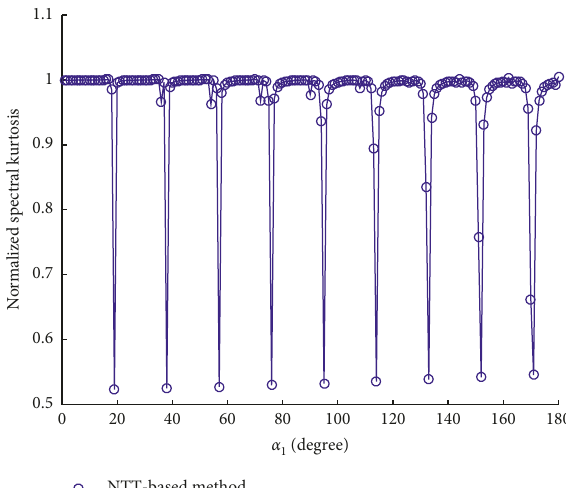
Figure 15: Normalized spectral kurtosis of nonuniformly recon- structed signals under different α 1